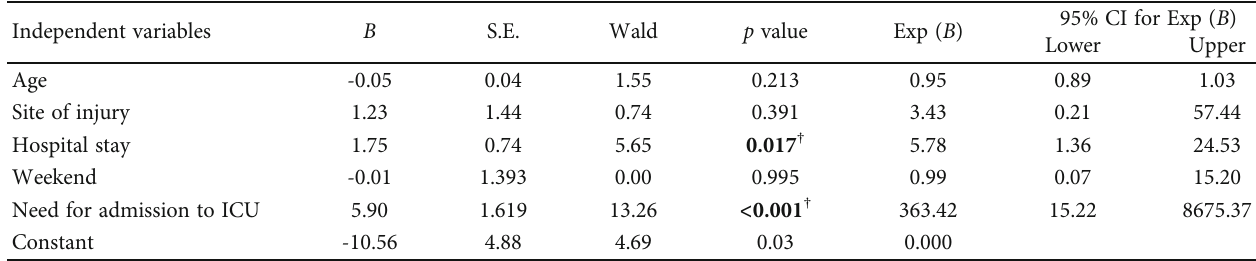
Table 6: Binary logistic regression parameters for head injury patients ’